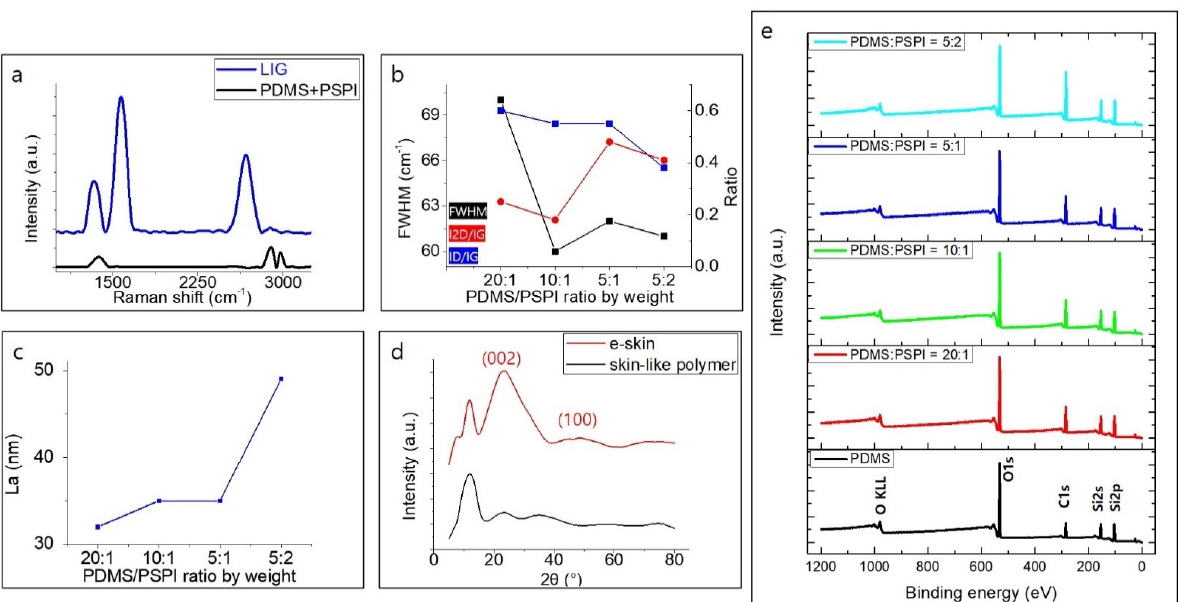
Figure 2. Characterizations of laser-induced graphitic pattern fabricated according to different weight ratio of polydime- thylsiloxane (PDMS)/photosensitive polyimide (PSPI); ( a ) Raman spectrum of an LIG pattern and the skin-like polymer, ( b ) statistical analysis of Raman spectra, ( c ) average domain size along the a-axis of graphene aerosol in the LIG pattern, ( d ) the XRD results of e-skin and the skin-like polymer, ( e ) XPS characteristics of the e-skin fabricated by according to the various weight ratio of PDMS/PSPI.